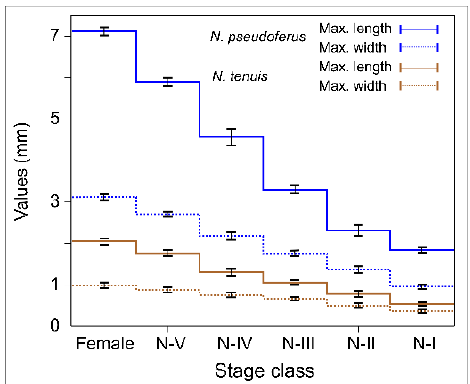
Figure 1. Average maximum lengths and widths (mm ± SE) of Nabis pseudoferus and Nesidiocoris tenuis according to their post ‐ embryonic development.